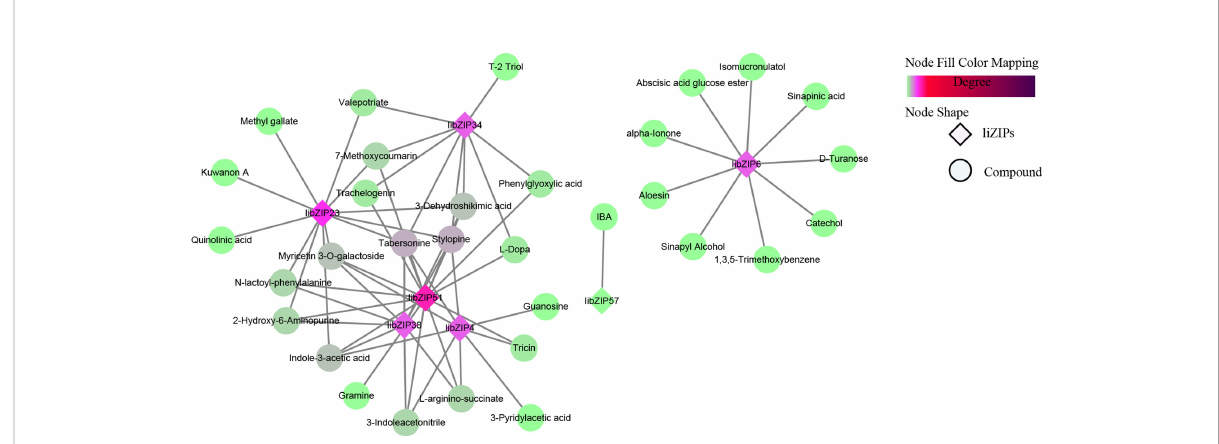
FIGURE 7 Pearson correlation network revealing the regulation by IibZIP genes of metabolite synthesis in leaves of I. indigotica under salt stress. Diamonds indicate IibZIP genes and circles indicate metabolites. The color shade indicates the number of genes associated with metabolites.